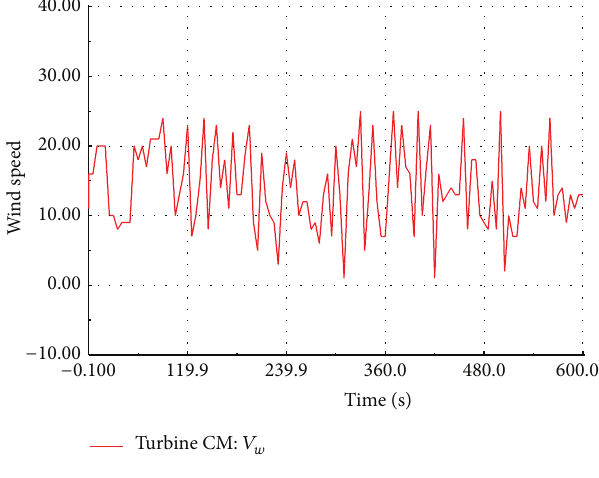
Figure 9: Simulated wind